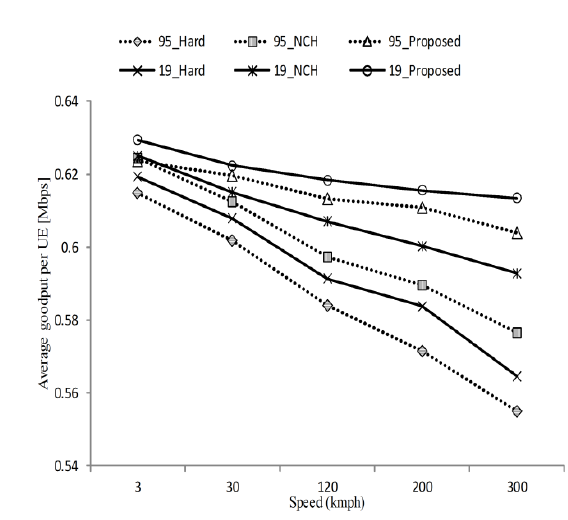
Fig. 10. The comparison of goodputs per